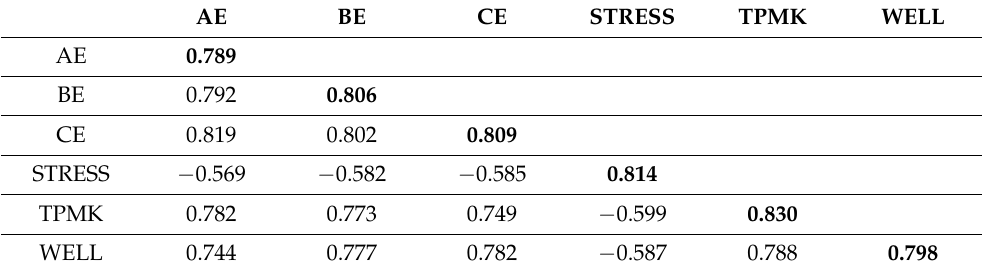
Table 4. Fornell–Lacker analysis